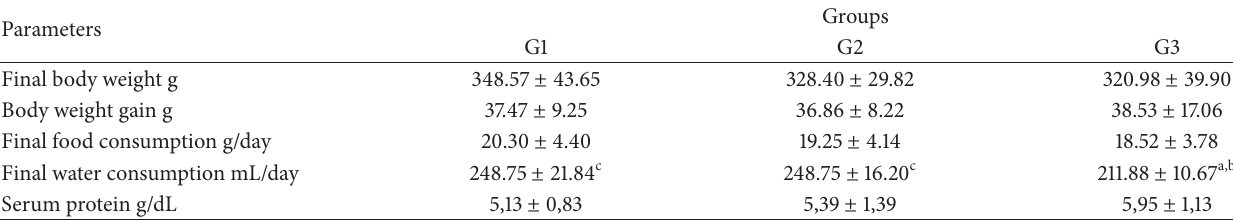
Table 1: General characteristics and serum protein levels after 30 days for all experimental groups.